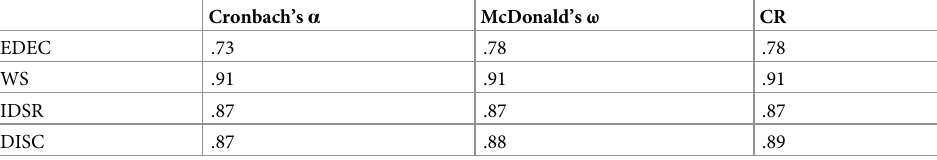
Table 2. Reliability coefficients of IDS-15 for each dimension.